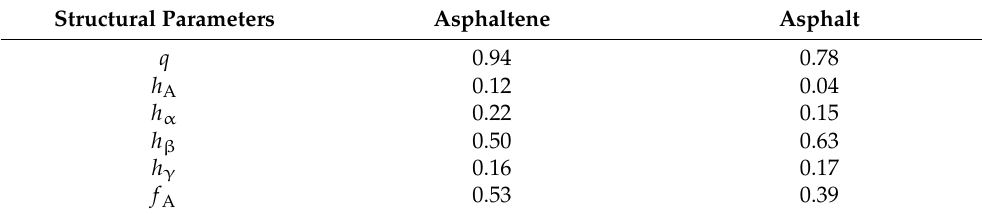
Table 3. Structural parameters of asphaltenes and base asphalt 1 .